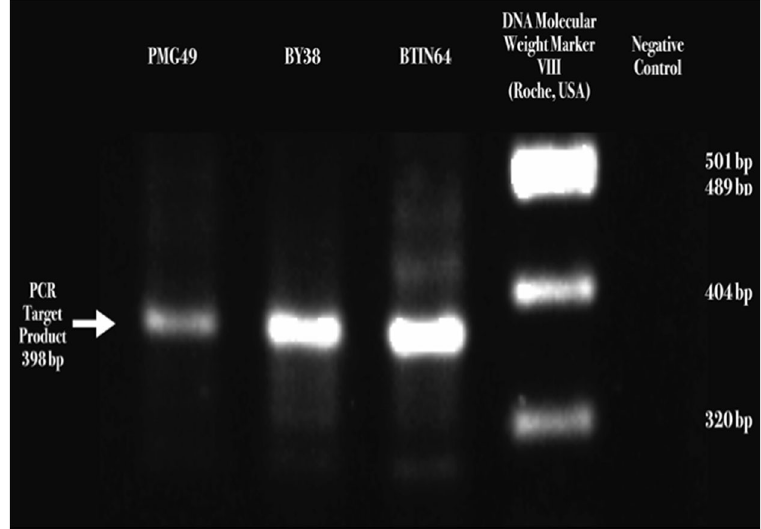
Figure 3. (A) Severe acute respiratory syndrome coronavirus 2 (SARS-CoV-2) S1/S2 cleavage site Receptor Binding Domain (RBD) detected by two-step reverse transcription-polymerase chain reaction (RT-PCR), DNA electrophoresis ethidium bromide staining, and visualized through the Gel Doc XR+ gel documentation system (Bio-Rad,